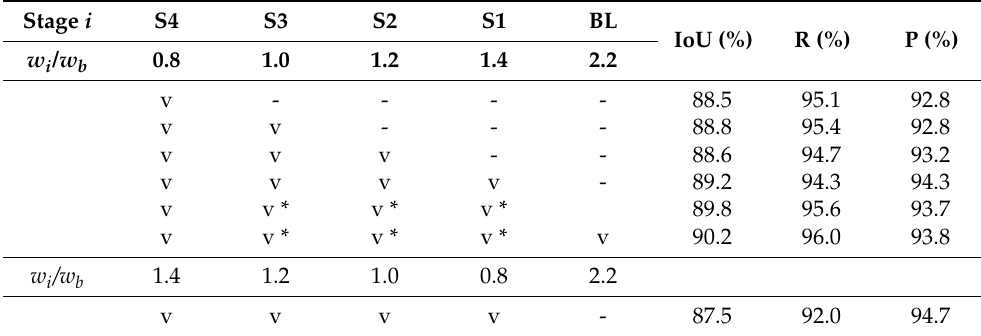
Table 8. Comparison of our model in each stage sequentially added with classification with different weights and added with boundary loss.